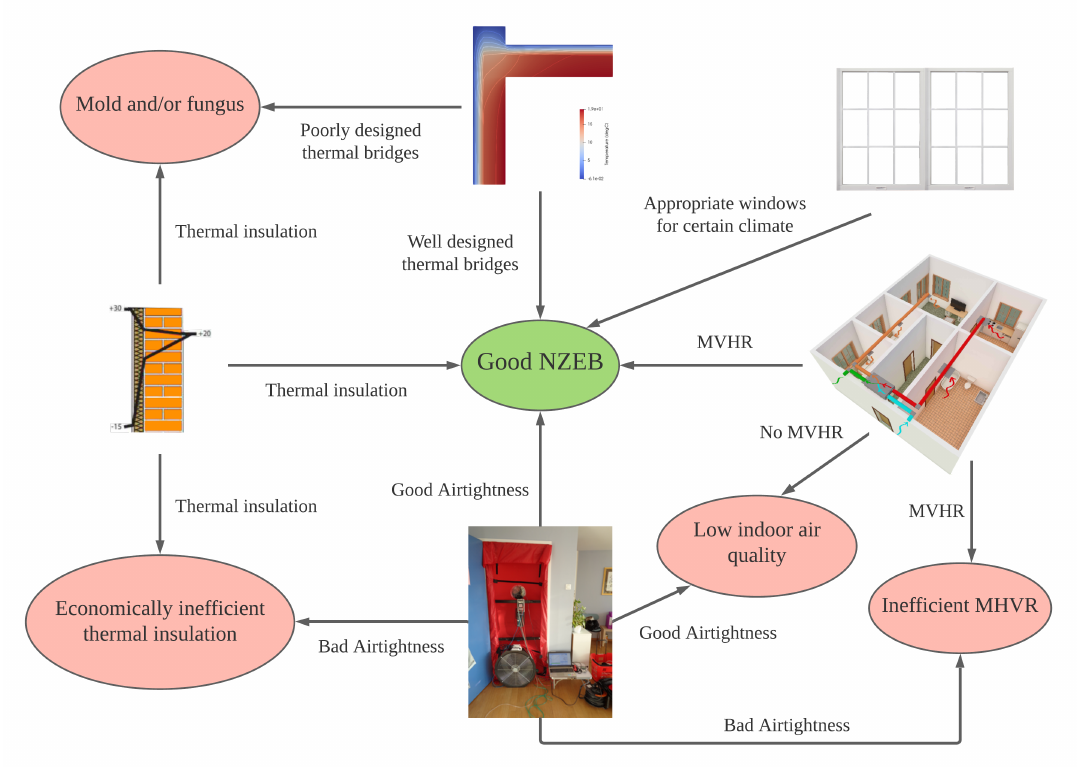
Figure 1. Schematic view of parameters that form good